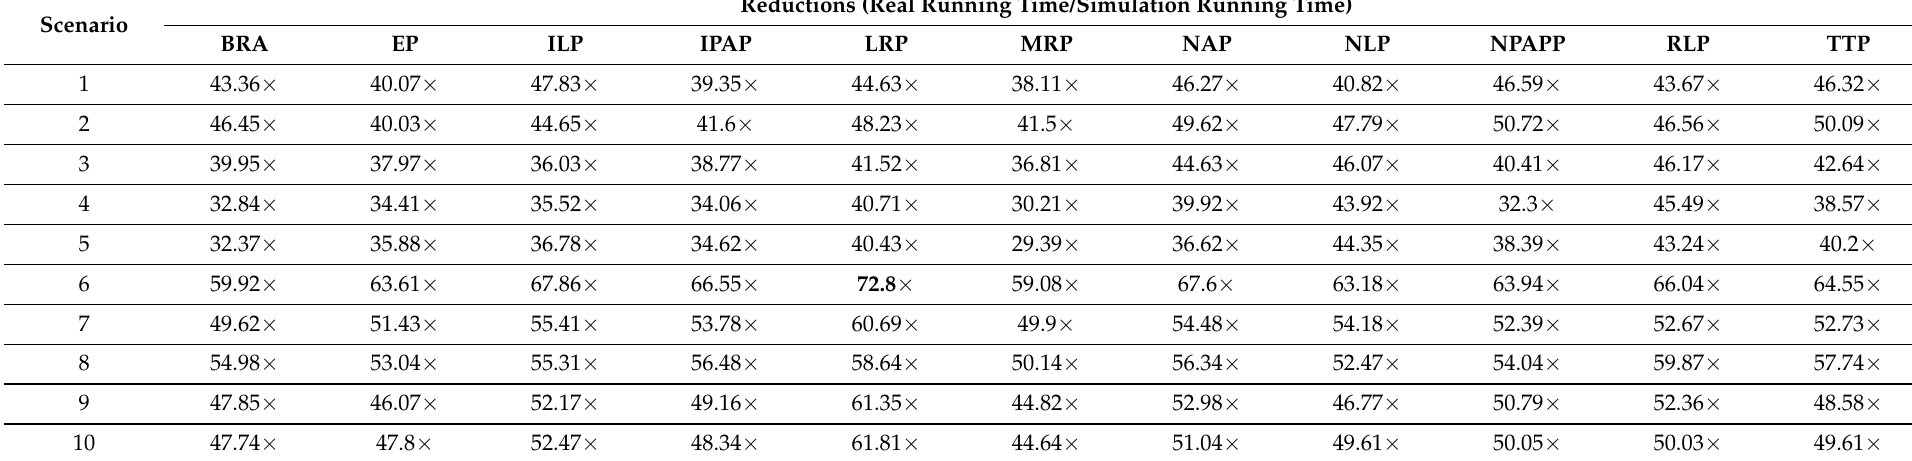
Table 4. Reductions in running time under TaskQueue workloads and changeable resources.